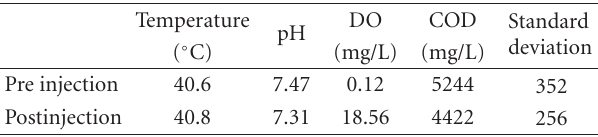
Table 1: Pre- and post-O 2 /O 3 injection measurements (O 3 loading rate of 0.053 g/min/liter water and O 2 loading rate